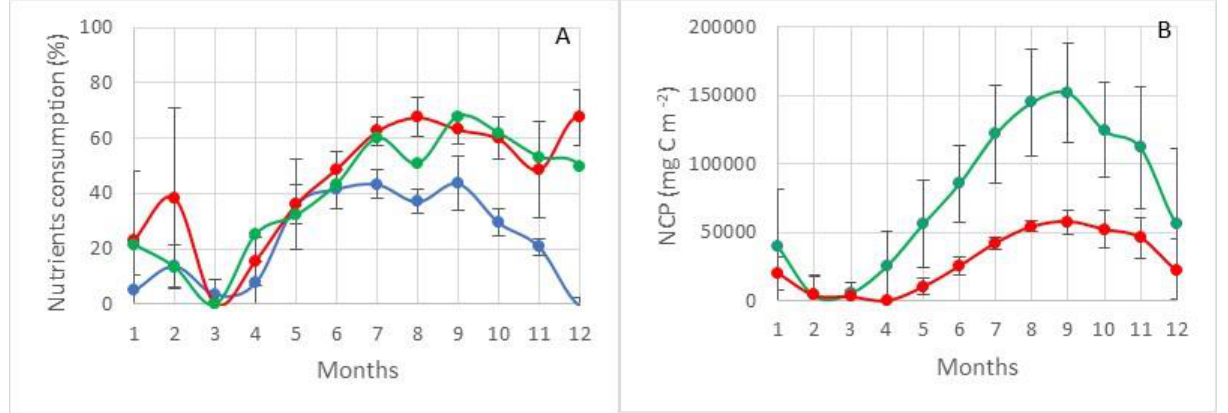
Figure 8. Annual cycle of primary production and nutrient consumption in the Region I: ( A ) con- sumed part of the nutrient supply in the process of photosynthesis (blue: mineral phosphorus, red: mineral nitrogen, green: silicon). ( B ) primary production (green: NCP Si ; red: NCP N ). The western border of the region is located on the slope of the depths. Depths in the water area vary here from 500 m or more in the west of the area to 25 m off the coast of